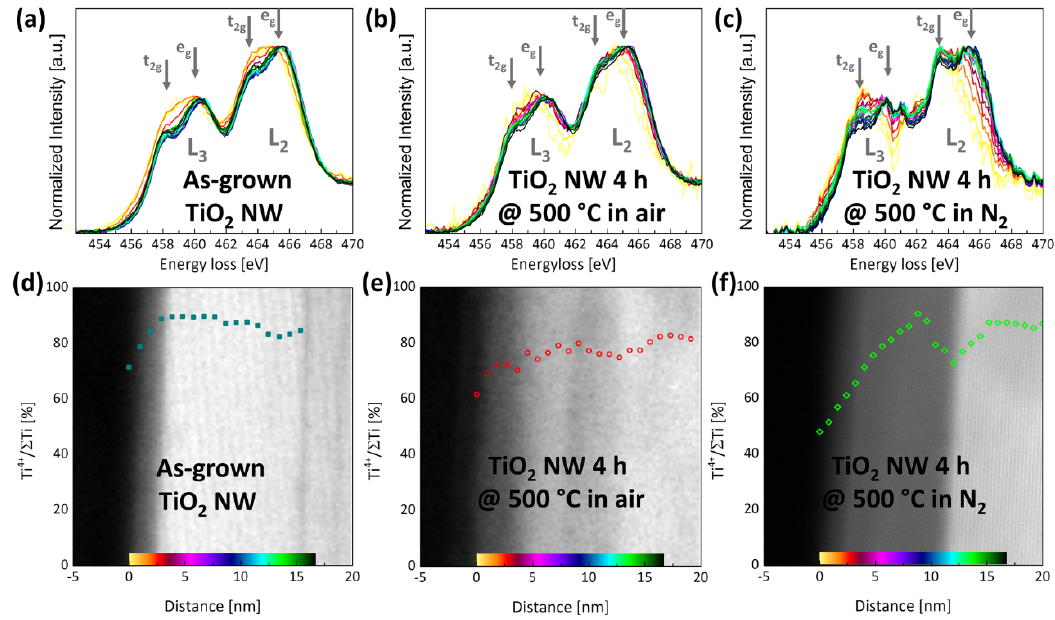
Figure 3. ( a – c ) Position resolved electron energy loss (EEL) spectra of the Ti-L 2,3 edge, for ( a ) an as-grown NW, ( b ) a NW annealed in air, and ( c ) a NW annealed in N 2 . The positions of the spectra are marked in the STEM images of ( d – f ) with a specific color, which is the same for the respective Ti-L 2,3 edge (the color changes from the NW surface to the center (left to right) in the following order: yellow, orange, red, pink, purple, blue, cyan, green, black). In ( d – f ), the Ti 4+ gradient is overlaid with the STEM image.